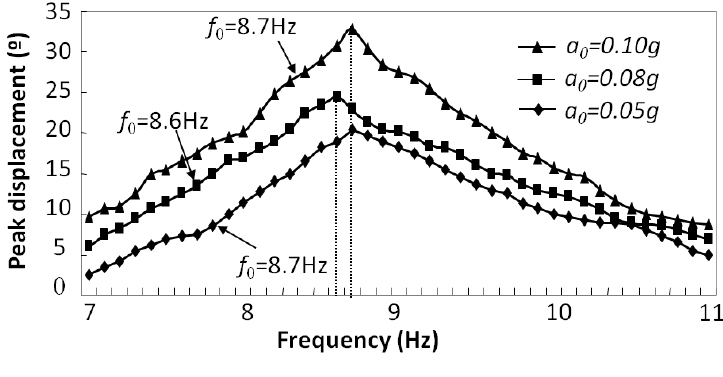
Figure 10. The frequency response of a liquid droplet based motion sensor, where the resonance frequency is around 8.7 Hz.